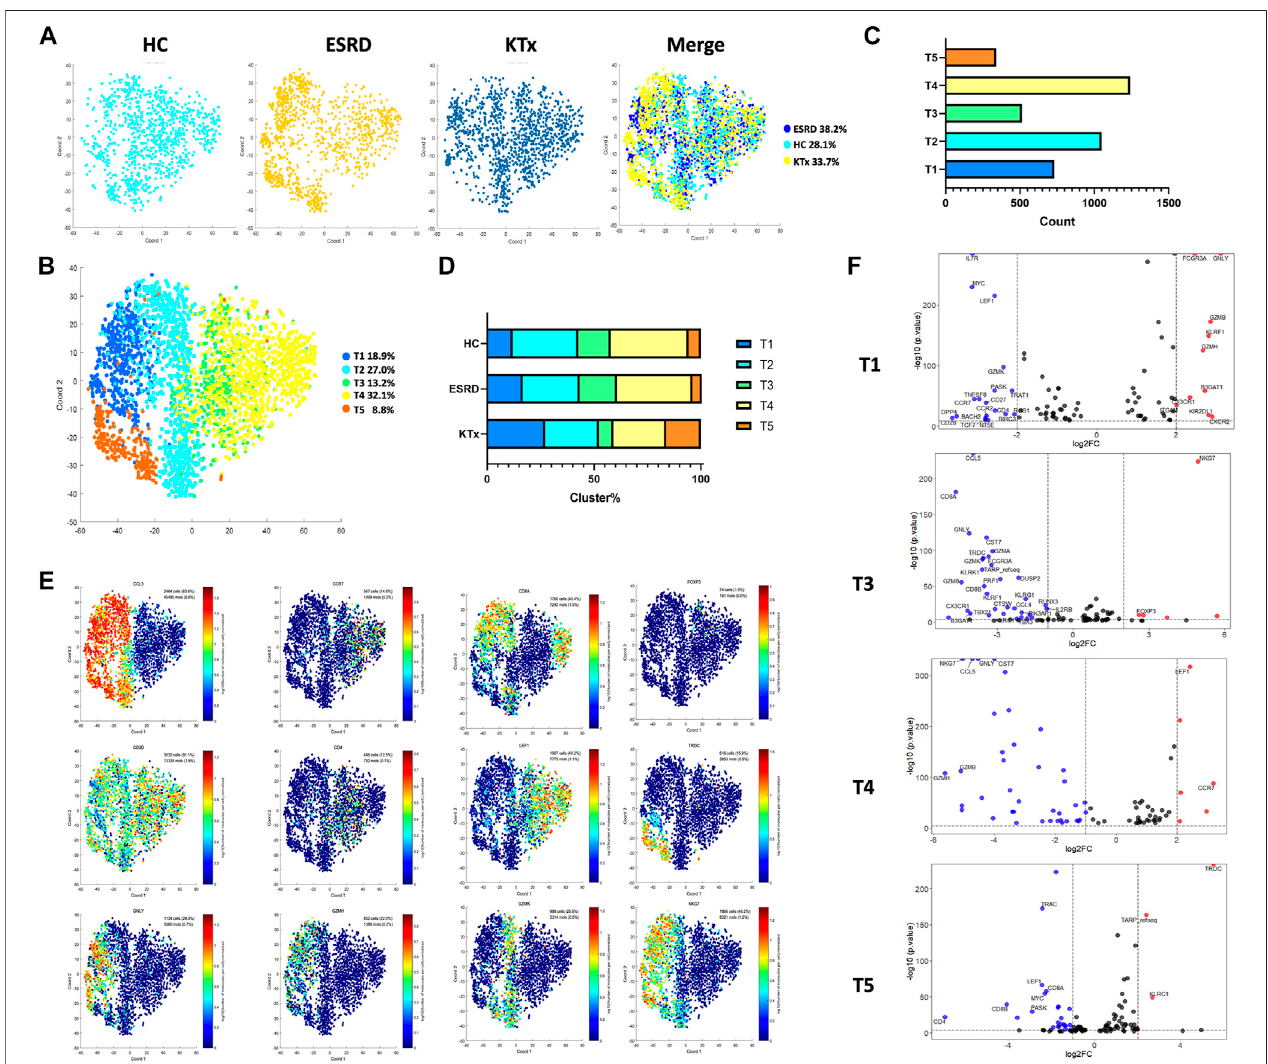
FIGURE 2 | T-cell clusters in PBMCs from HC, ESRD, and KTx. (A,B) tSNE of single-cell pro fi le with each cell color coded for T-cell subsets. (C) Cell count of 5 T-cell subsets. (D) Distribution of 5 T-cell subsets. (E) Expression of highly expressed genes in each T-cell cluster. (F) Gene fi ngerprint expression volcano map of T1, T3, T4, and T5